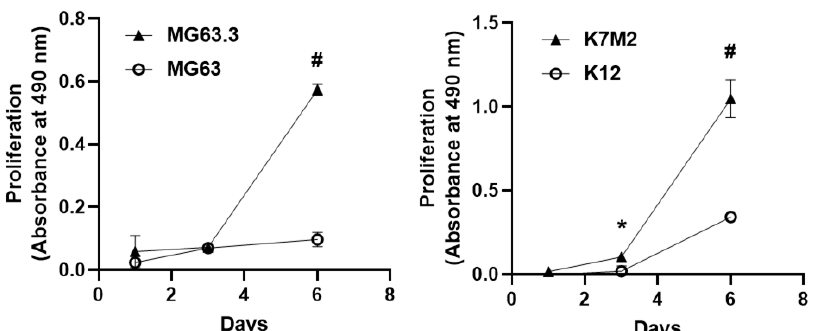
Figure 1. Comparison of growth kinetics of high and low metastatic potential OS cells in the 3D BME system. Growth kinetics of matched human (MG63 — low; MG63.3 — high) and murine (K12 — low; K7M2 — high) osteosarcoma cells were observed over a 6-day period in the 3D BME system. Matched cells were plated under the same conditions and assessed for proliferation on days 1, 3, and 6 using an MTS assay. Highly metastatic cells undergo outbreak after 3 days exhibited by the high rate of proliferation from days 3–6, while low metastatic lines were growth arrested or displayed low rates of proliferation. These graphs are from a single representative assay (replicates = 4) with n = 3 biological repeats with similar results (* p < 0.05; # p < 0.005).